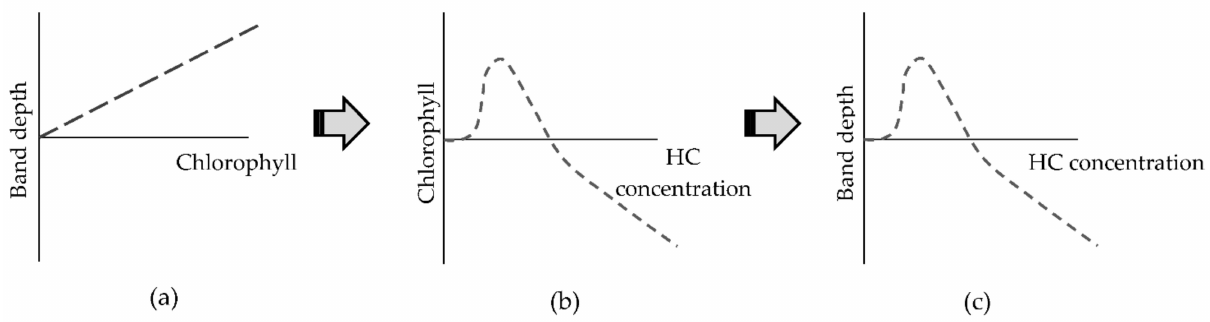
Figure 10. Indicative relationships between band depth, chlorophyll, and hydrocarbon concentration from day 14 to 28 after the addition of hydrocarbon pollution into the soil. As an example, chlorophyll content and the related band depth are used here. ( a ) Relationship between band depth from absorption feature and chlorophyll content. ( b ) Relationship between chlorophyll content in the plant and hydrocarbon concentration in soil. ( c ) Relationship between band depth of absorption feature and hydrocarbon concentration in soil. (HC: hydrocarbon